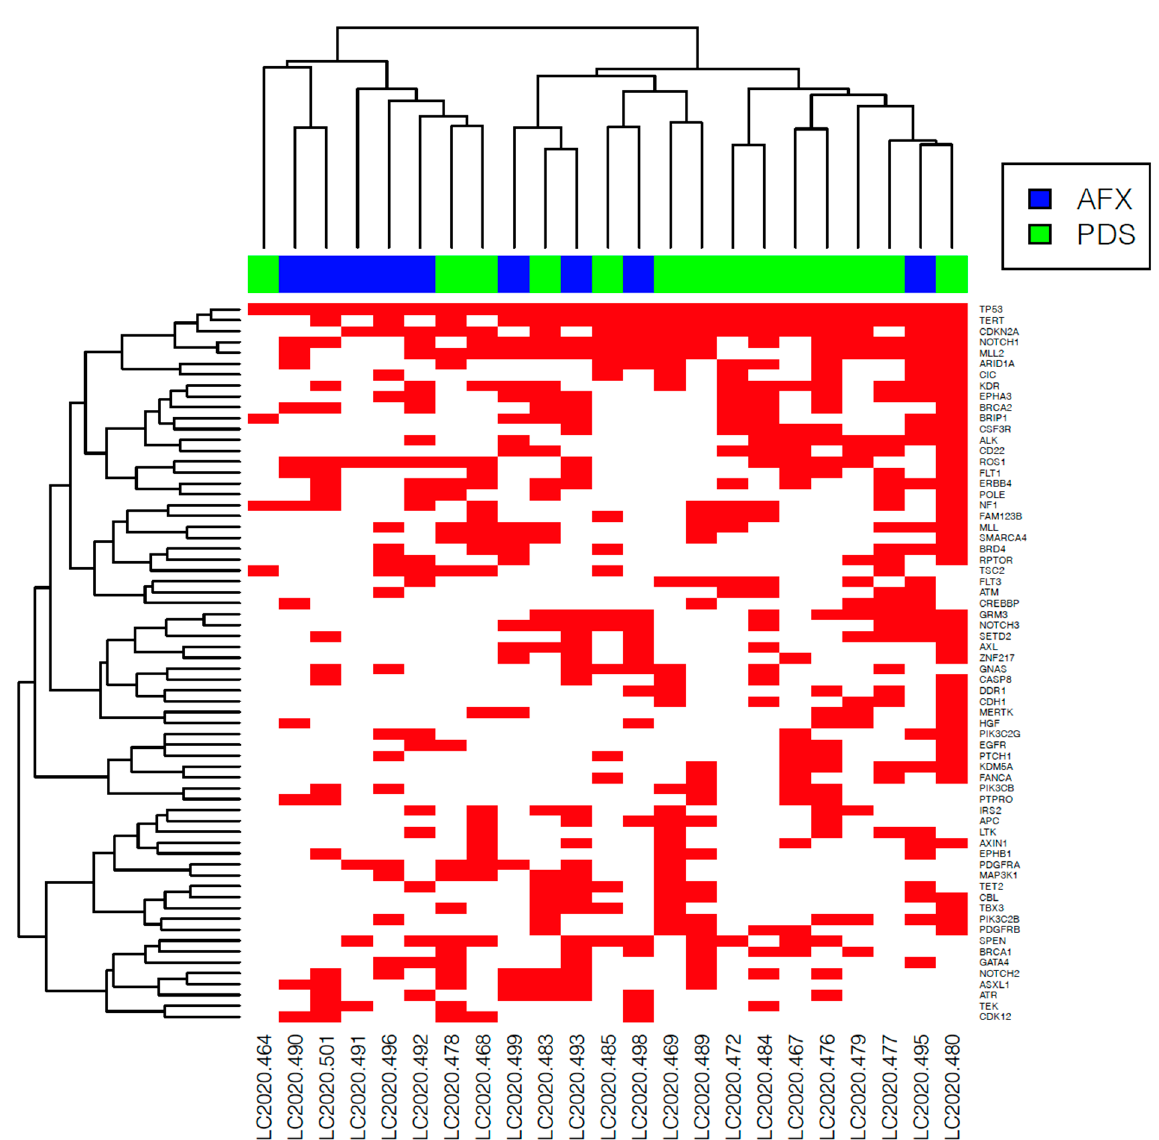
Figure 6. Heatmap of all identified gene alterations in the analyzed cohort. The red box marks the presence of a gene alteration.